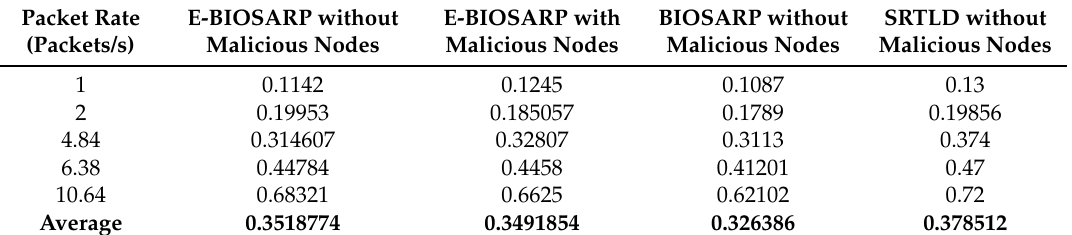
Table 7. Energy consumption comparison.